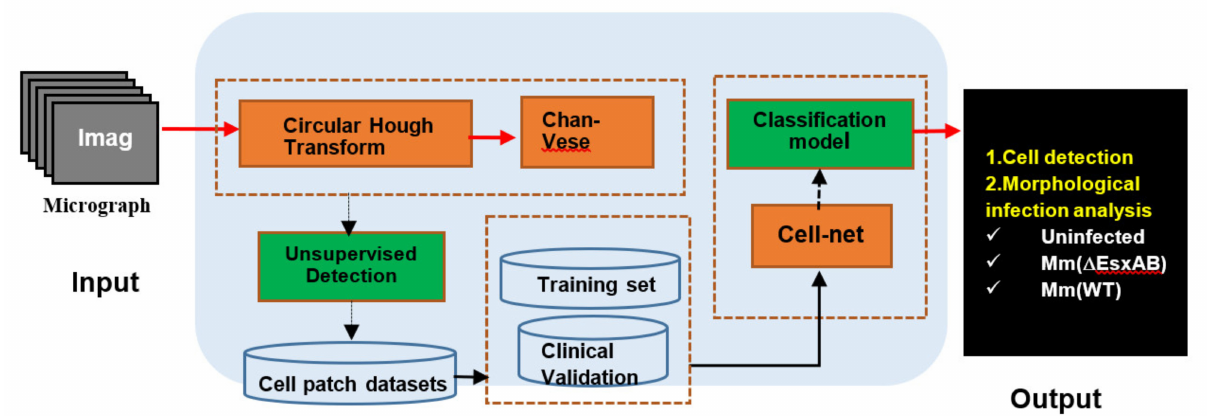
Figure 2. The diagram of algorithms and data in the